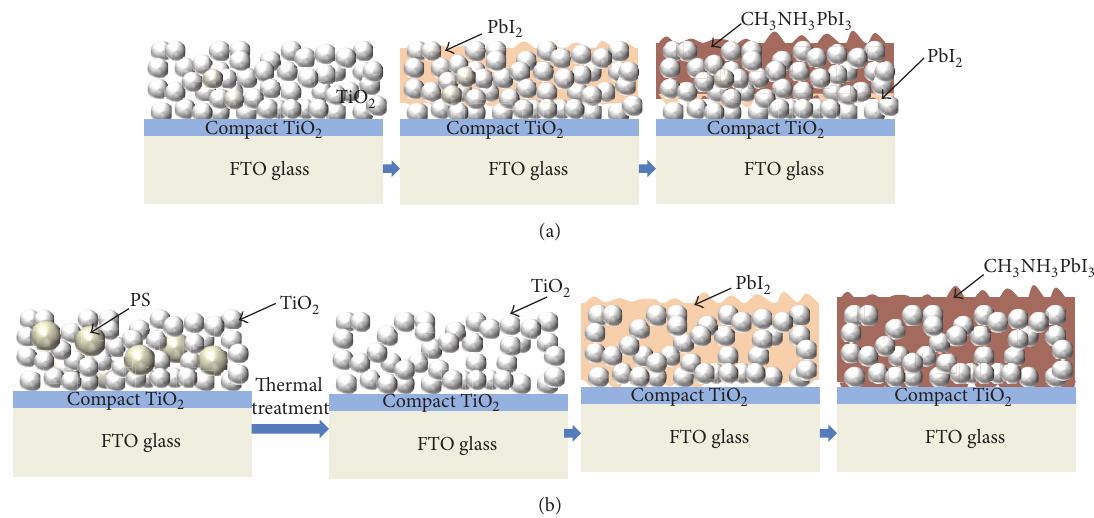
Figure 1: Schematic illustration of the distribution of PbI 2 and TiO 2 in mp-TiO 2 film (a) without and (b) with PS